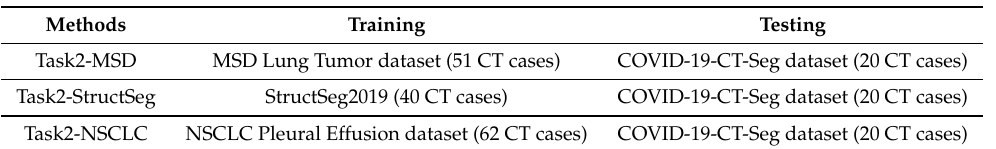
Table 3. Experiment settings of learning deep models with only non-COVID-19 CT scans for automated infection segmentation.